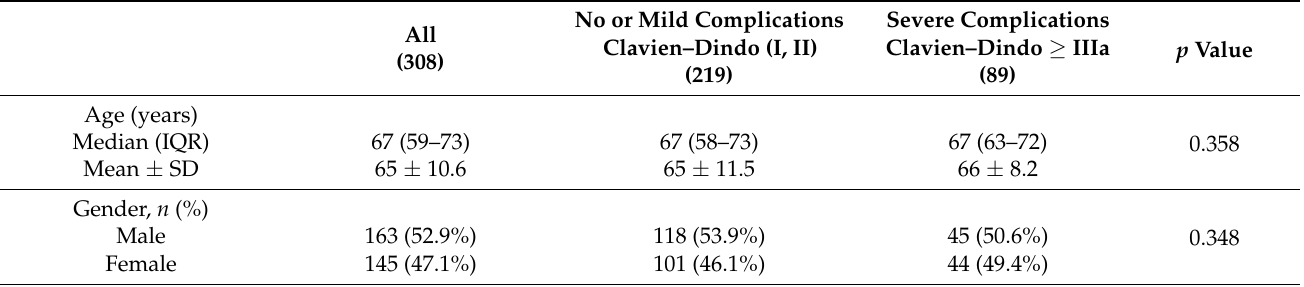
Table 1. Baseline characteristics of the study